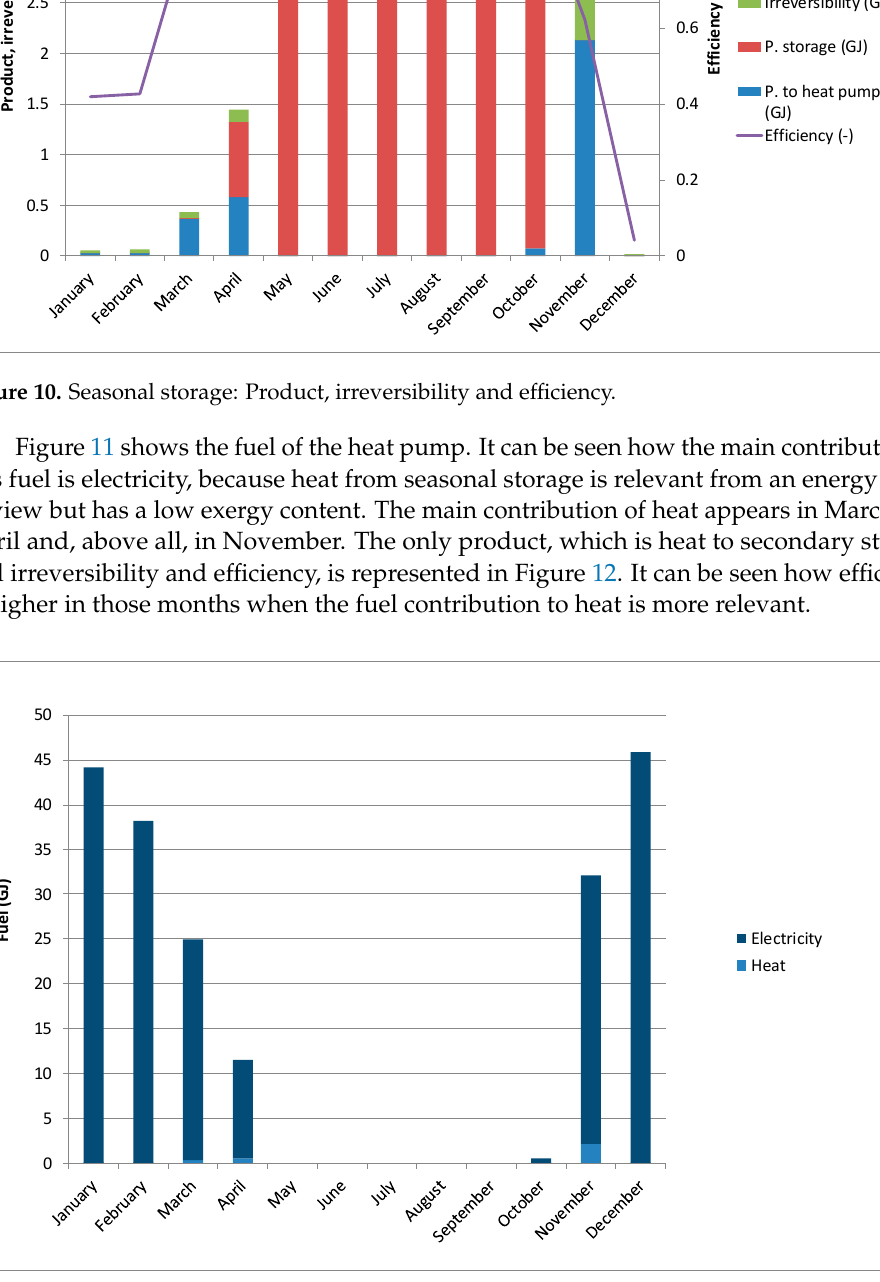
Figure 11. Heat pump: Fuel.